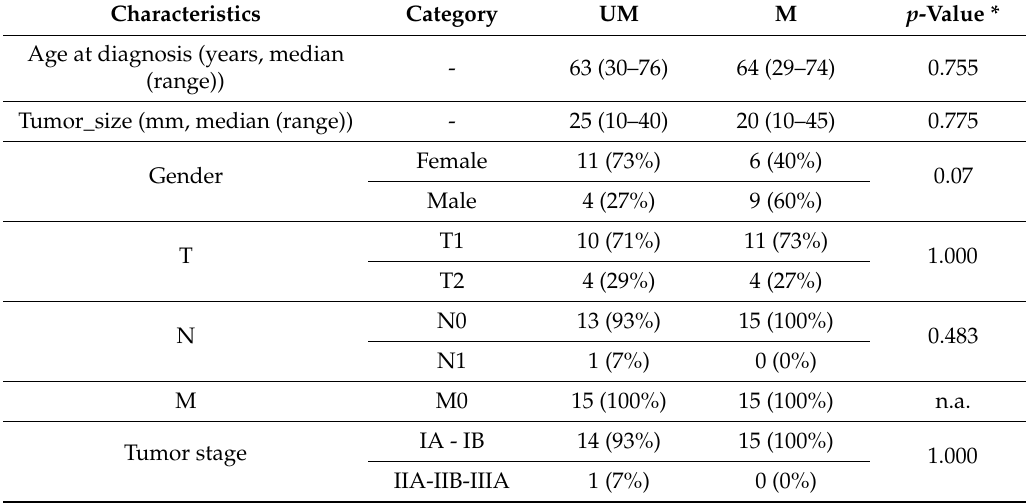
Table 3. Clinical pathological characteristics for patients with typical carcinoid ( n = 30), according to. their KEAP1 methylation